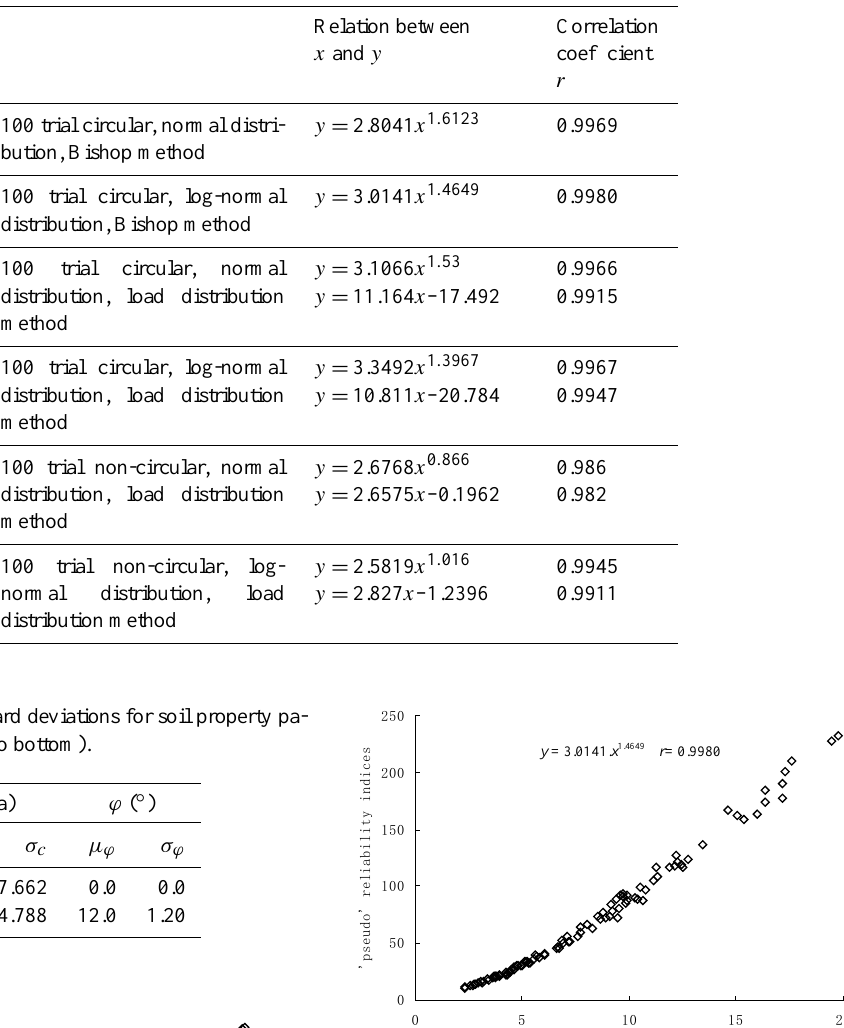
Table 3. Relations between pseudo reliability indices and true reliability indices.